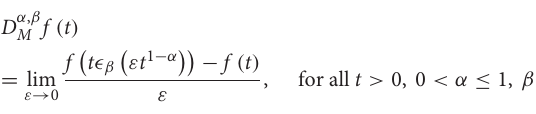
FIGURE 8 | 2-D, 3-D, and contour plot of Equation (28), when t 1 γ 0.2, α , β 0.6 and z 3 = = =